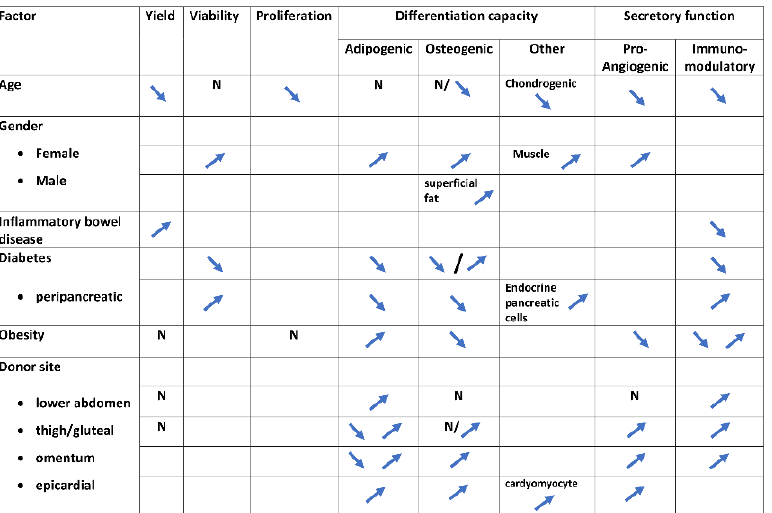
Figure 1. ADSC characteristic alterations by individual donor factors. Schematic summary of the reviewed literature. N—not significantly altered; Upstream arrow—potentiation of the characteristic; Downstream arrow—inhibition of the characteristic.